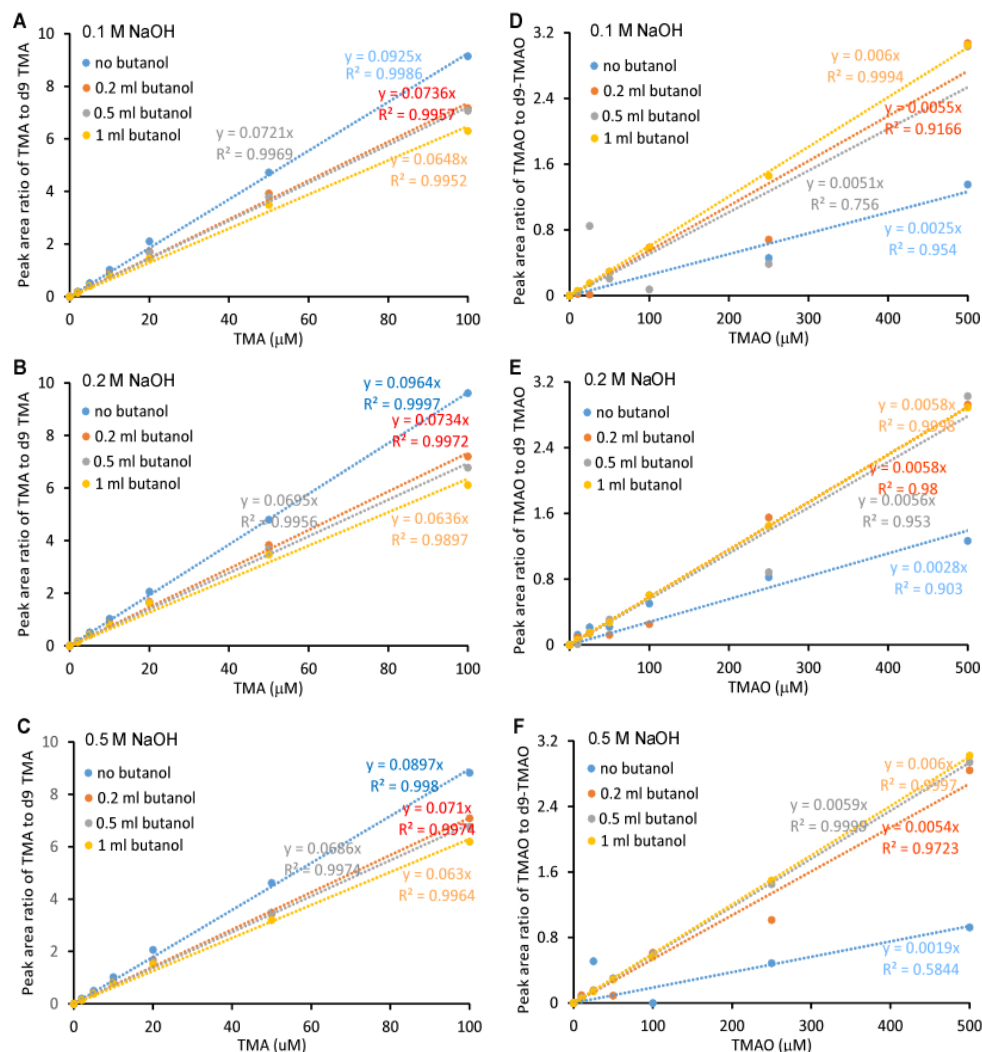
Figure 3. Standard curves for the Liquid Chromatography Electrospray Ionization Tandem Mass